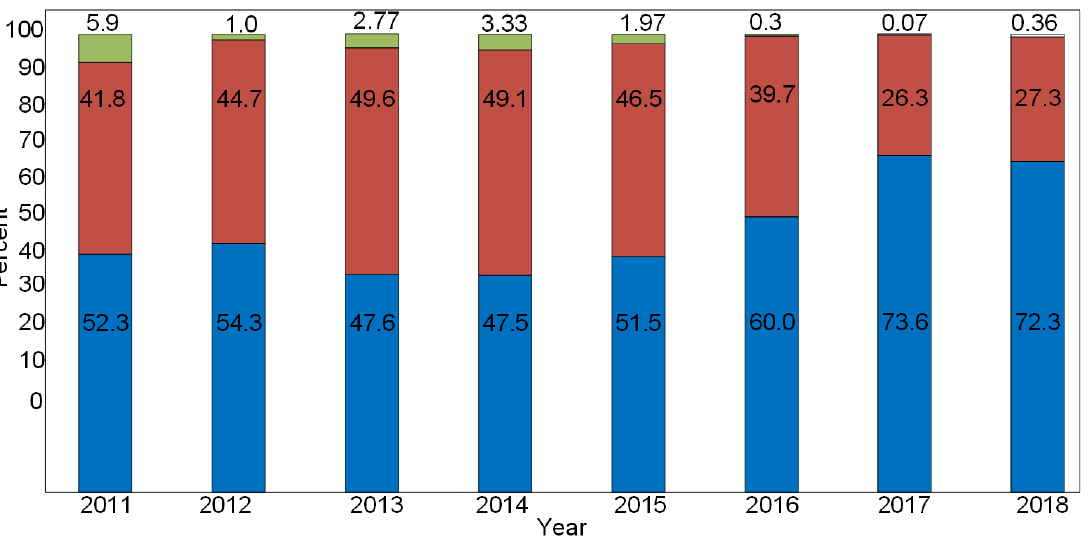
Figure 18. Percentage composition of electricity generation in Ecuador.